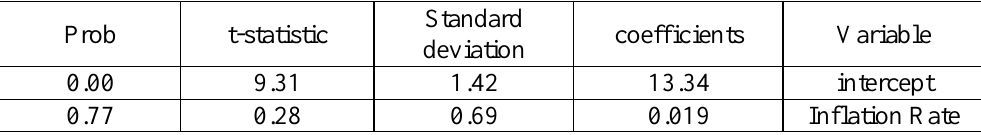
Table 8. Results of Equation Four: Facility Interest Rate as Dependent Variable t-statistic